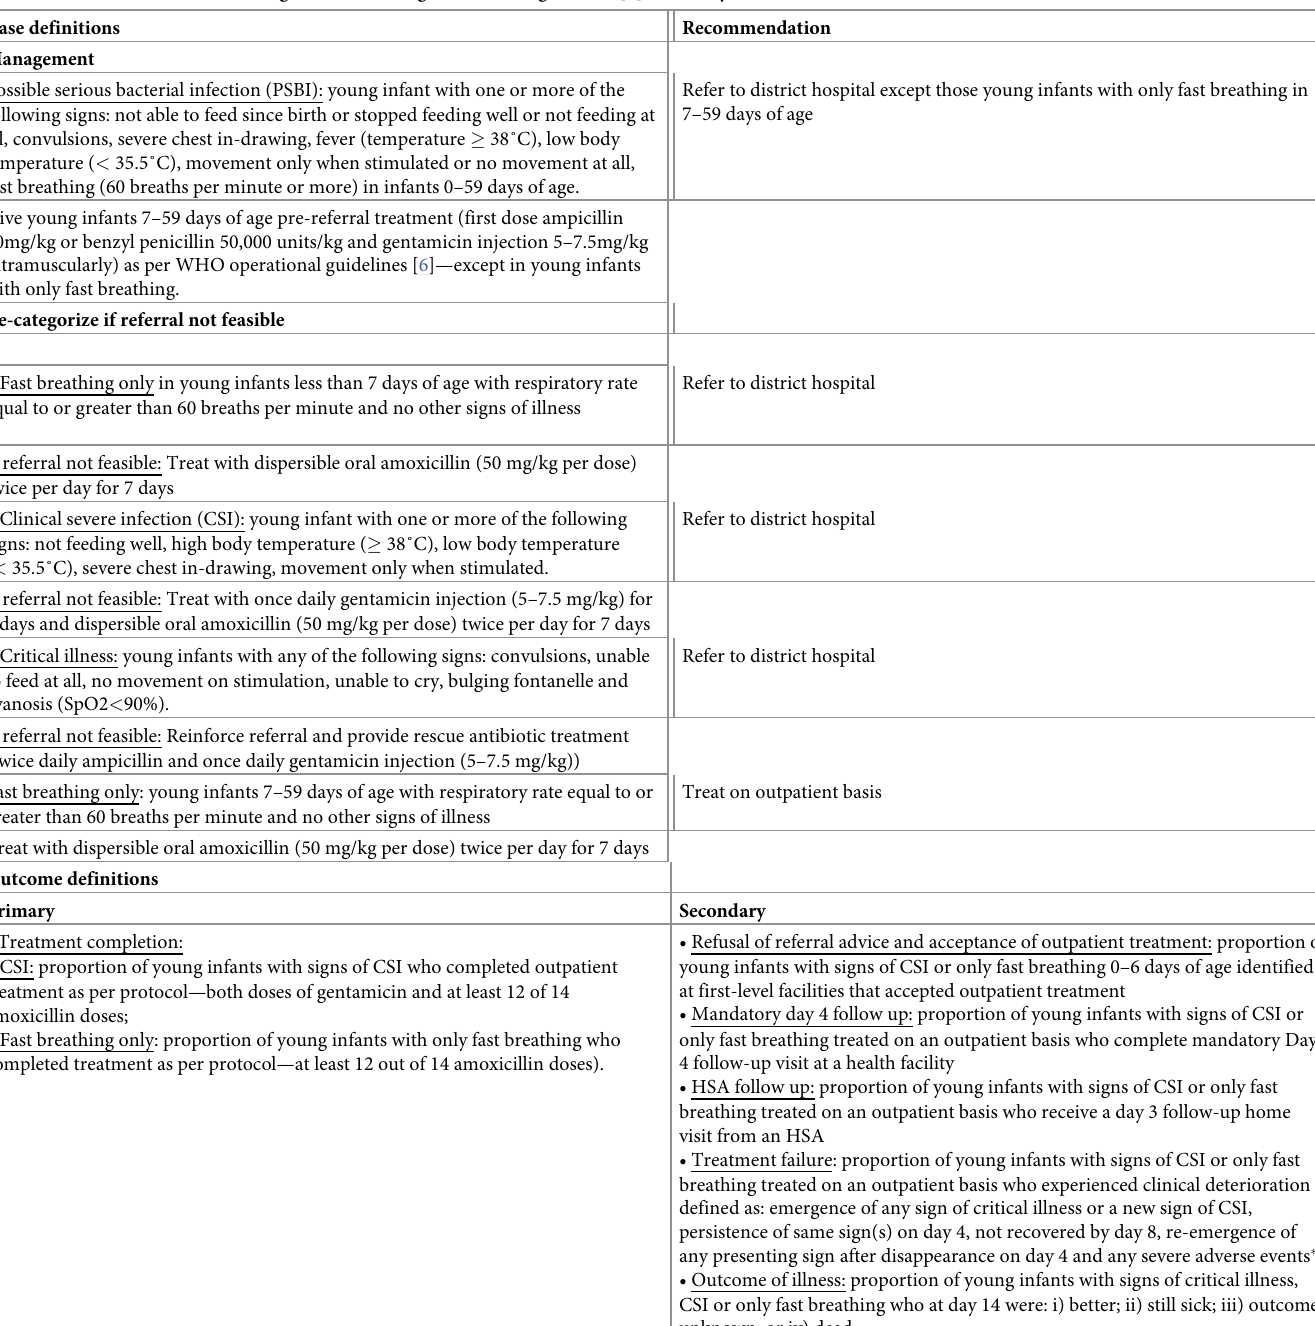
Table 1. Case definitions and management according to the WHO guideline [3] and study